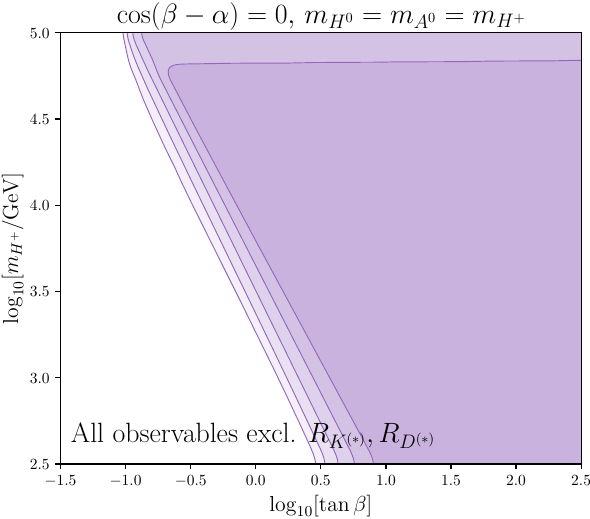
Figure 10 . Combined fit of all flavour observables (excluding R and EWPOs in the 2HDM-I (in the tan β − m α ) = 0 ) and degenerate masses ( m parameter space at 1,2,3,4,5 σ confidence from darkest to